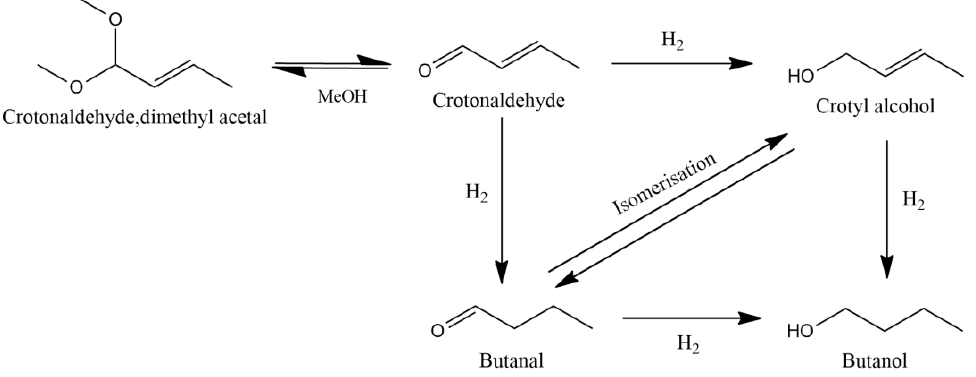
Figure 1. Reaction scheme for the transformation of crotonaldehyde.